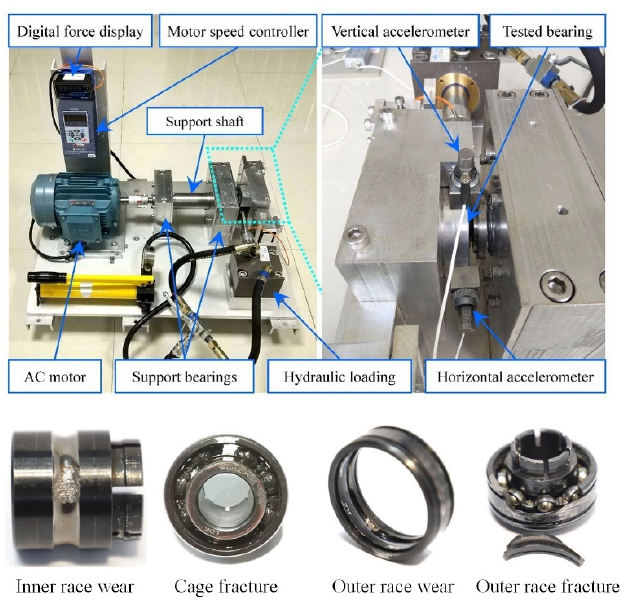
Figure 8. The test platform system of bearing.